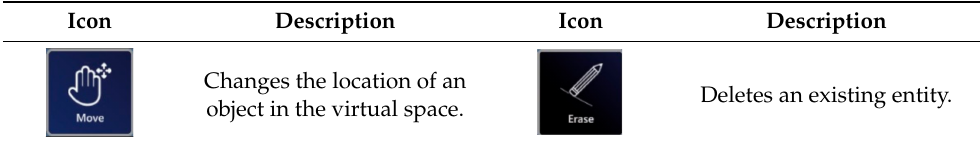
Table 3. Available commands to edit geometry.